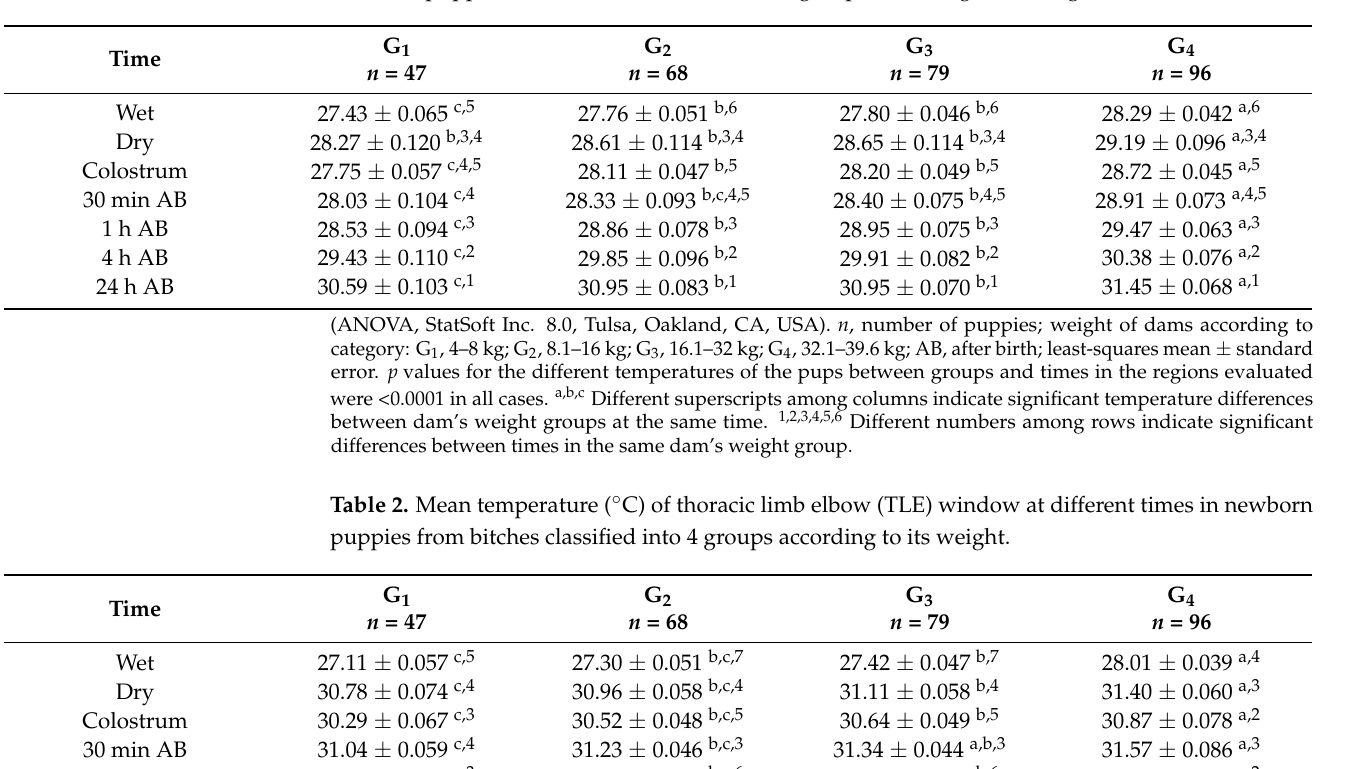
Table 1. Mean temperature ( ◦ C) of thoracic limb brachial biceps (TLBB) window at different times in newborn puppies from bitches classified into 4 groups according to its weight.